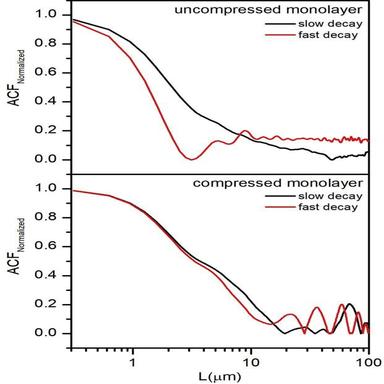
The autocorrelation functions (ACFs) of 5CB/CNC nanocomposite at the air-water interphase calculated for uncompressed (upper panel) and compressed (lower panel) film.